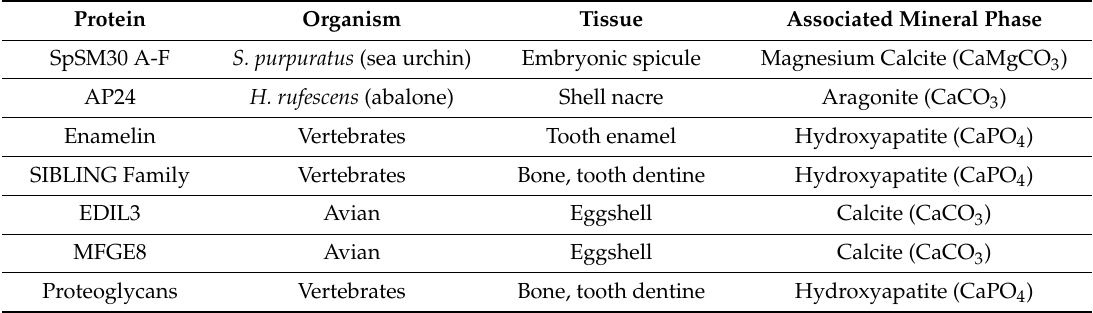
Table 2. Biomineral-associated